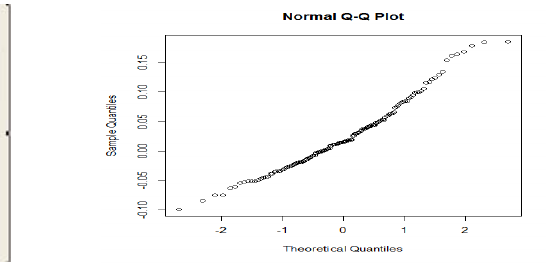
Fig. 1. Testing the normality of data